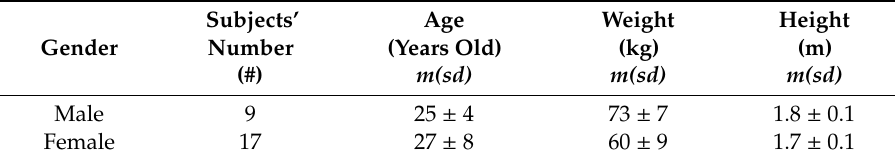
Table 1. Sample population.